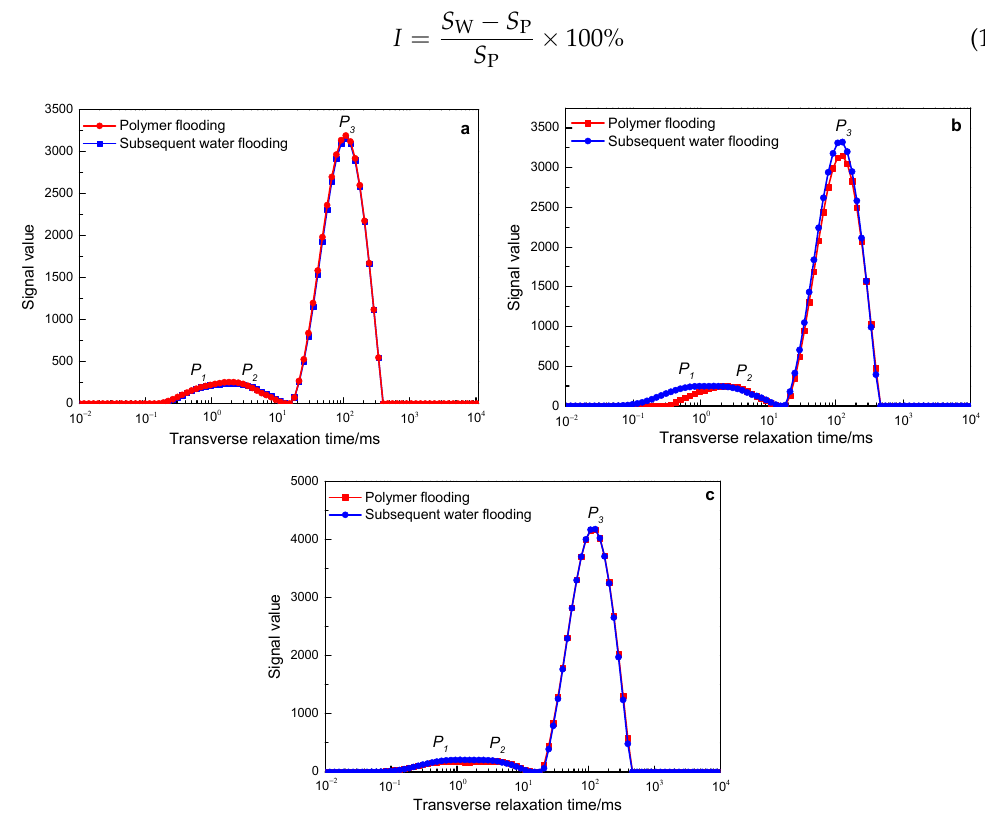
Figure 10. The change characteristics of the NMR T 2 spectrum curves of the polymer solution with a molecular weight of 19 million in rocks with different permeability after polymer flooding and subsequent water flooding: ( a ) 500 mD core; ( b ) 1000 mD core; ( c ) 2000 mD core. I —Sweep volume increase rate, %; S P , S W —NMR T 2 spectrum peak area of